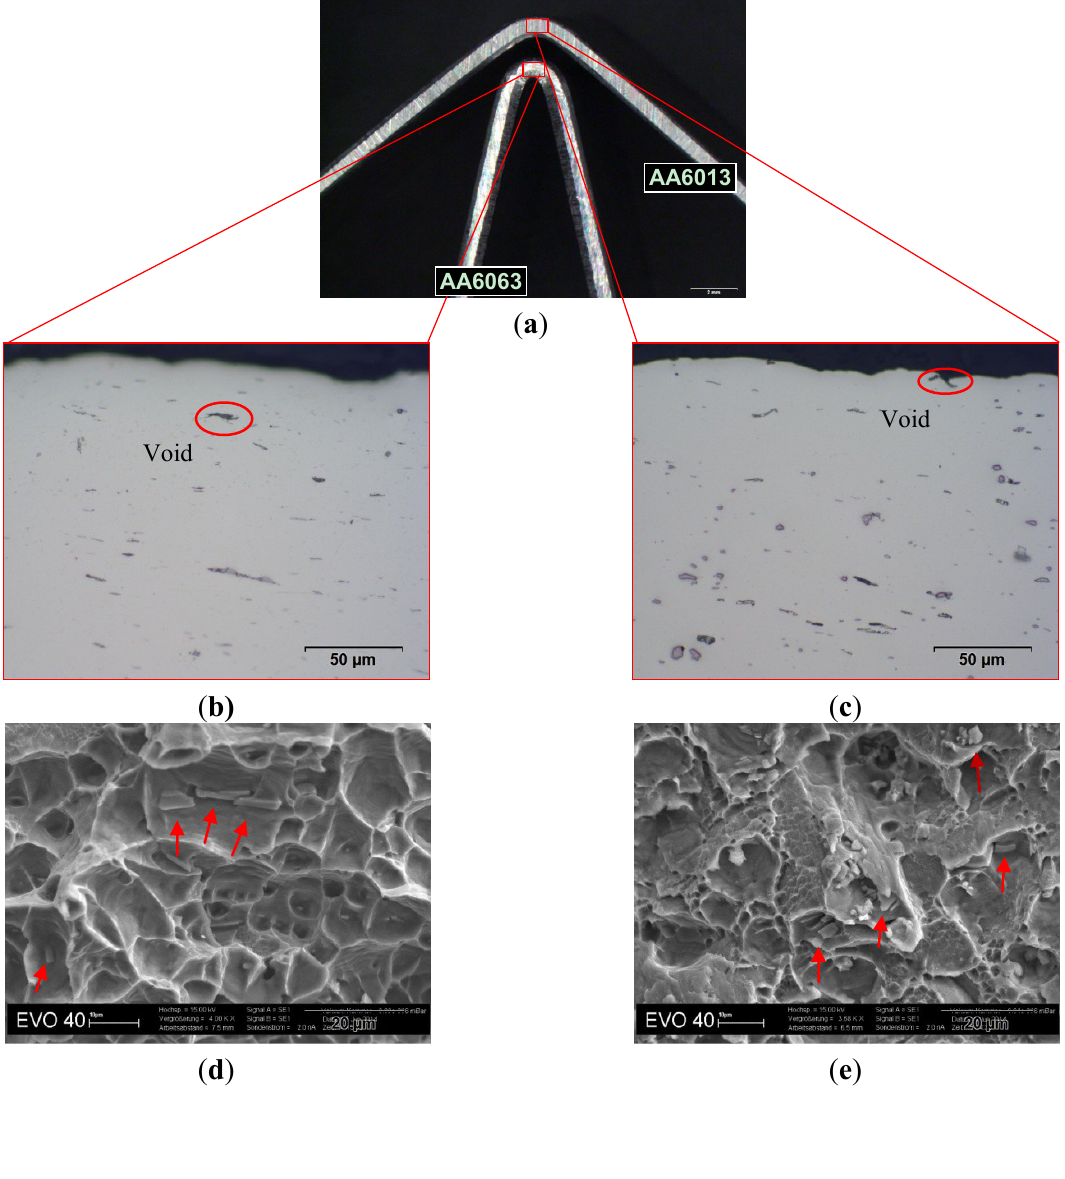
Figure 15. Microstructure observations on bending test samples of AA6063 and AA6013 in T4*. ( a ) Bending samples of AA6063 and AA6013 in temper T4*; ( b ) optical micrograph in the L-direction of AA6063 in T4* near the fracture surface, 500×; ( c ) optical micrograph in the L-direction of AA6013 in T4* near the fracture surface, 500×; ( d ) SEM micrograph of the fracture surface of AA6063 in T4*, red arrows = Al-Fe-Si, 4,000×; ( e ) SEM micrograph of the fracture surface of AA6013 in T4*, red arrows = Al-Fe-Si-Mn-Cu 4000×; ( f ) SEM micrograph of the undeformed microstructure of AA6063 in T4*, 1,000×, white = Al-Fe-Si particles dark = Al-Si-Mg particles; ( g ) SEM micrograph of the undeformed microstructure of AA6013 in T4*, 1,000×, white = Al-Fe-Si-Mn-Cu particles black = Al-Mg-Si-Cu